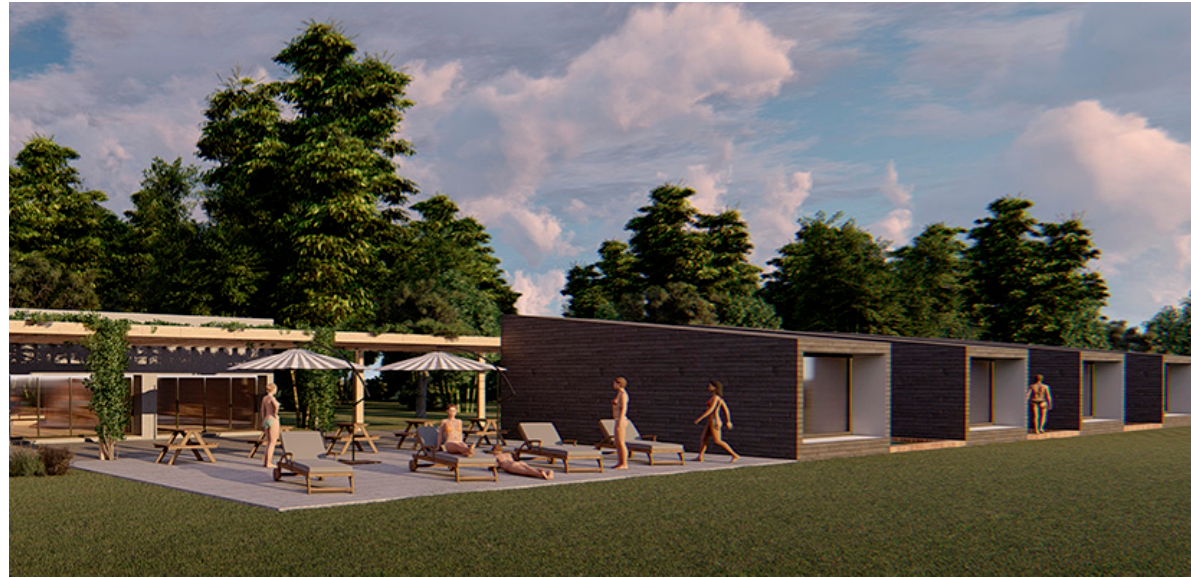
Figure 11. Visualization of proposed model for wellness and spa facilities.